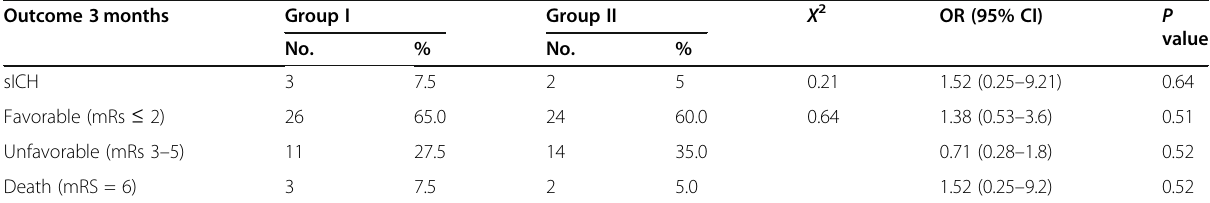
Table 2 Outcome at 3 months among both studied groups Outcome 3 months